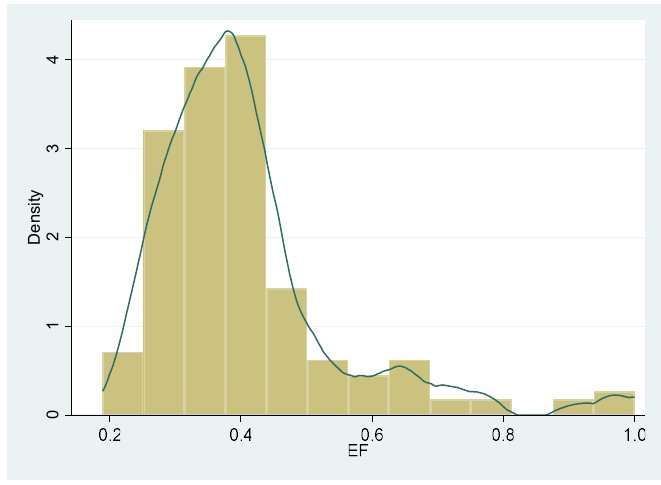
Figure 1. Histogram for the efficiency scores (EF) of Vietnamese banks (2007–2019).